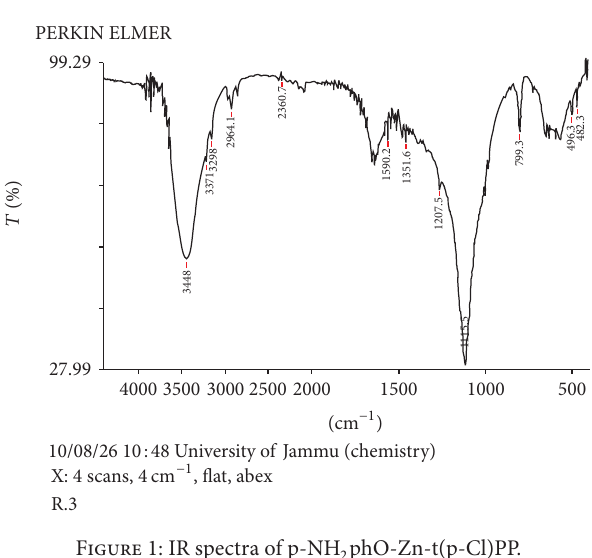
F 1: IR spectra of p-NH F 2: IR spectra of p-NH